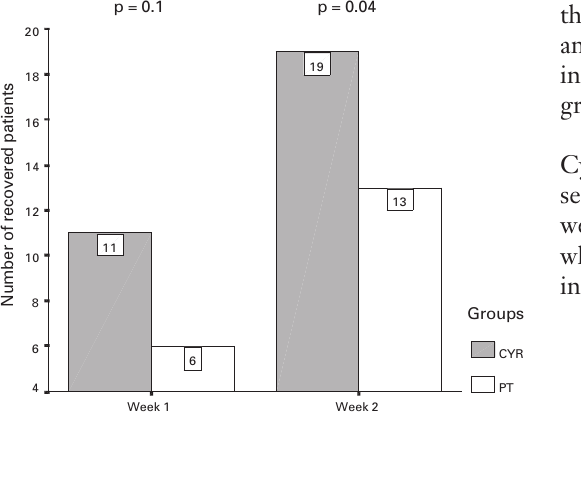
The efficacy of the two different thera- pies over